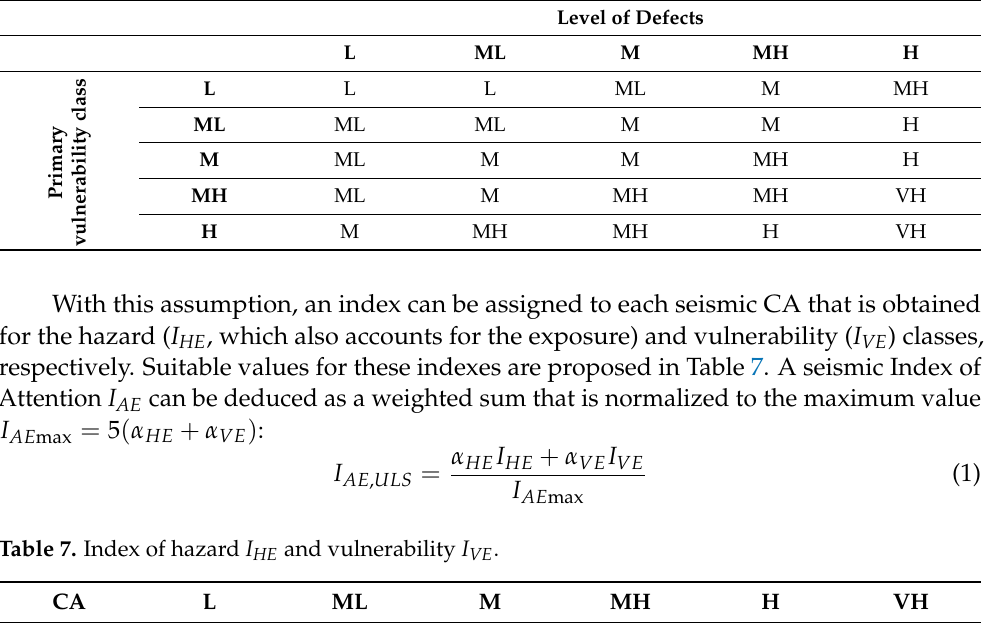
Table 6. Vulnerability class of attention which also includes the VH class.